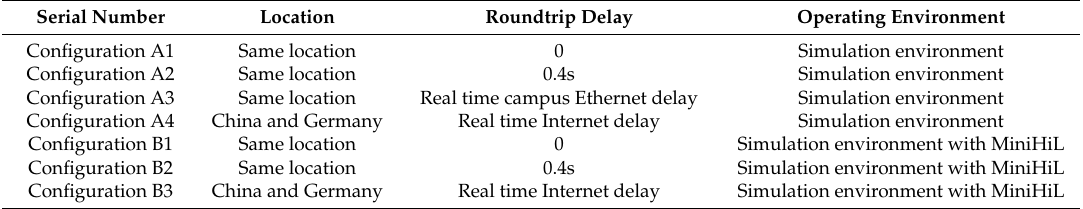
Table 8. Configuration settings on location, hardware and